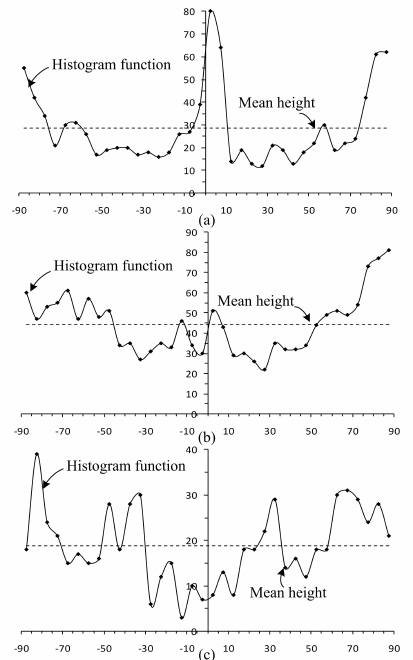
Figure 6: Gradient histogram functions and means for rectangles (a) B 1 , (b) B 2 and (c) B 3 in Fig. 5(b): x -axis is in degrees and y -axis is in pixels (bin